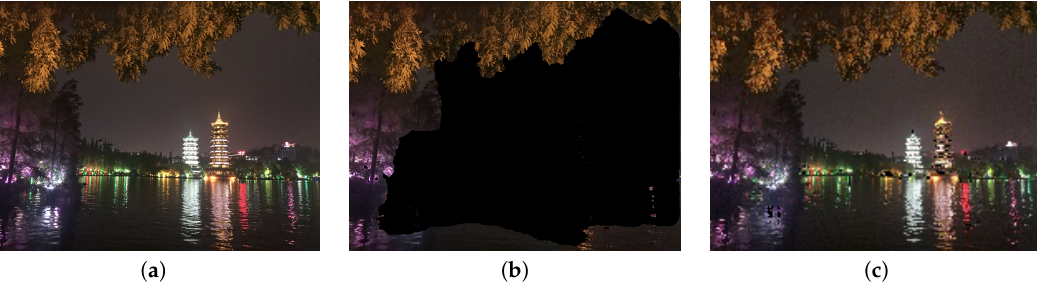
Figure 38. Results of extracting the foreground in a frame-within-a-frame composition method using different resolutions. ( a ) Original image, with the resolution of 1200 × 1600. ( b ) The extracted foreground result using ( a ). ( c ) The extracted foreground result using a reduced resolution of 171 × 228.